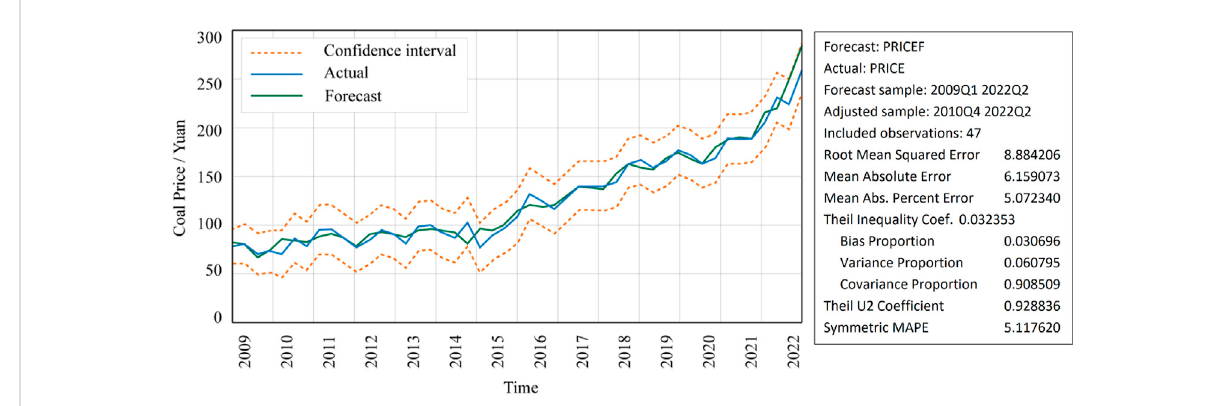
FIGURE 11 The result of the coal prediction model based on ARIMA.